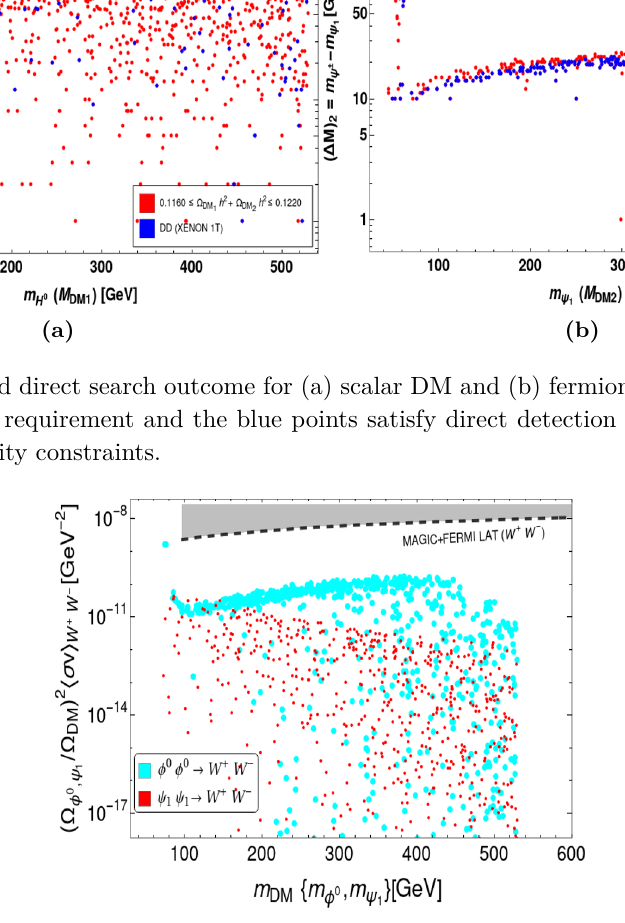
Figure 8. Regions allowed by indirect detection constraints from W + W − mode for scalar and fermionic DM. Their individual contributions have been scaled by their respective number